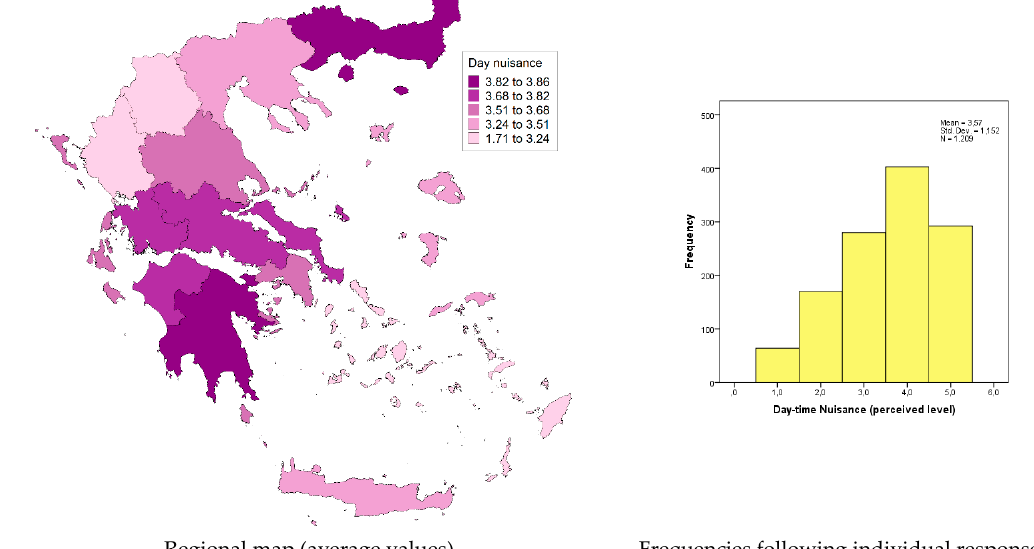
Figure 3. Day nuisance (Likert scale 1–5: 1, no nuisance; 5, intolerable nuisance).